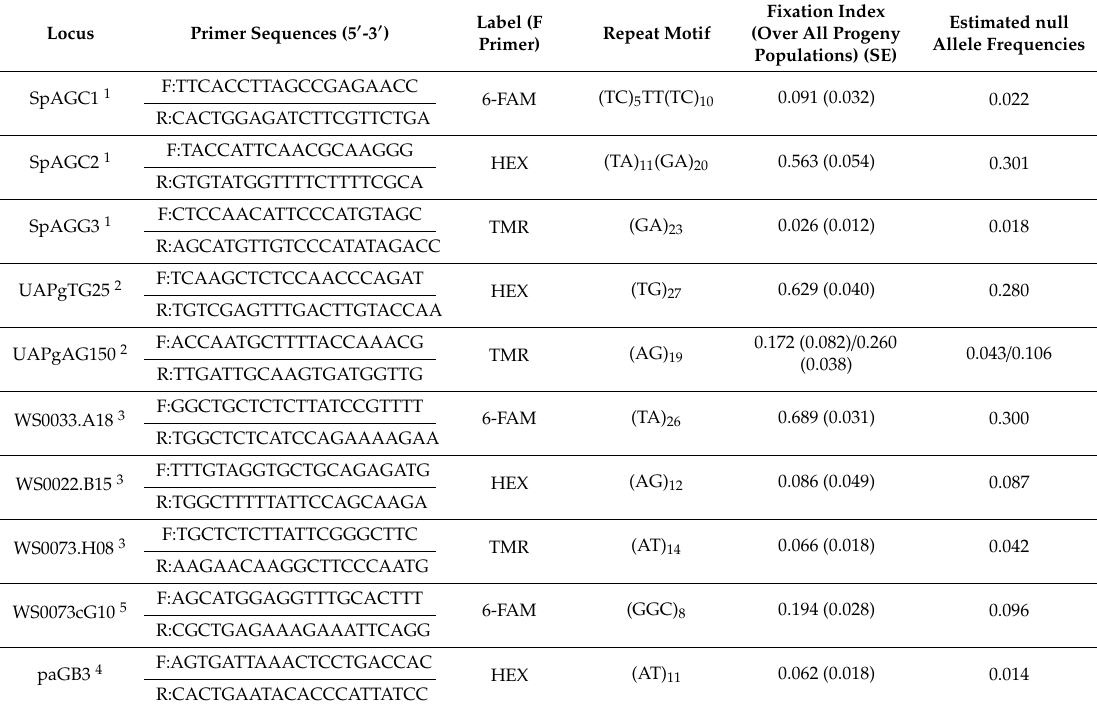
Table 2. Microsatellite loci utilized for genotyping spruce